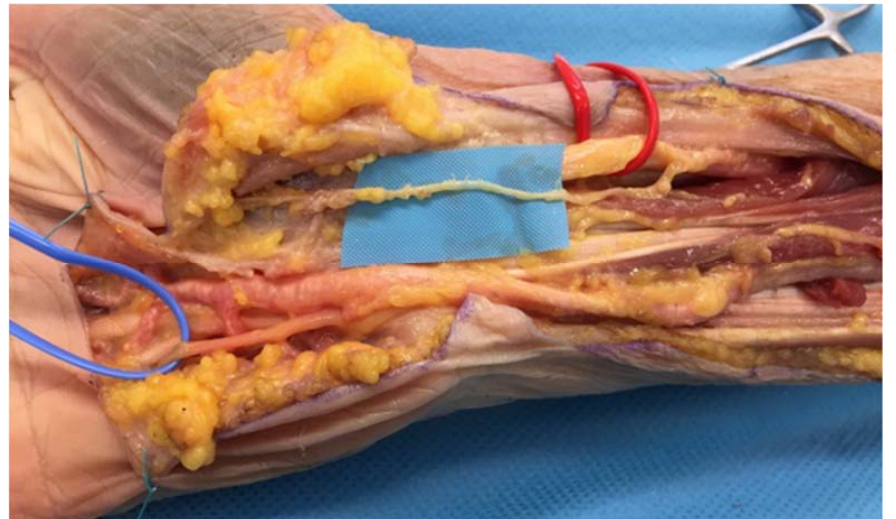
Figure 5. Release of the palmar cutaneous branch of the median nerve. The SBUN was isolated in the blue loop. The median nerve was identified (red loop) and the palmar cutaneous branch was released as far as possible.